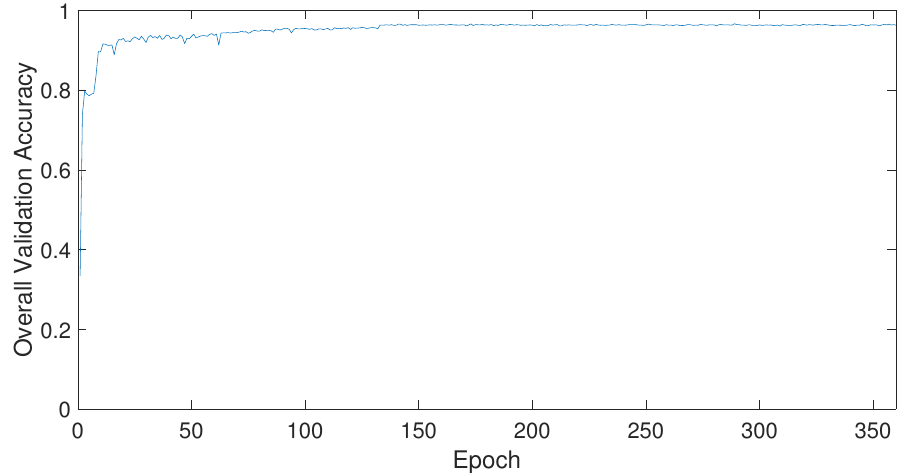
Figure 6. Epochs versus validation